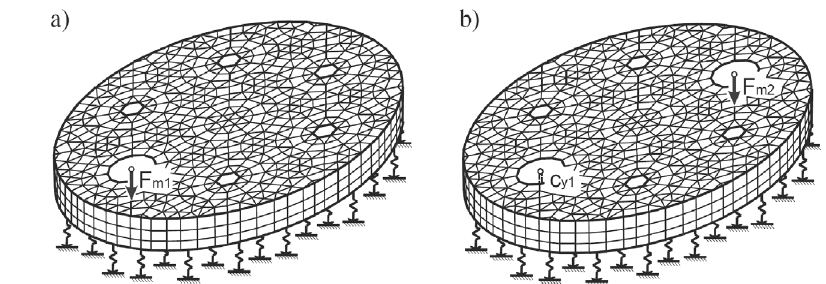
Fig. 2. Start of the assembly process: a) preloading of the first bolt, b) preloading of the second bolt Rys. 2. Początek procesu montażu: a) napinanie pierwszej śruby, b) napinanie drugiej